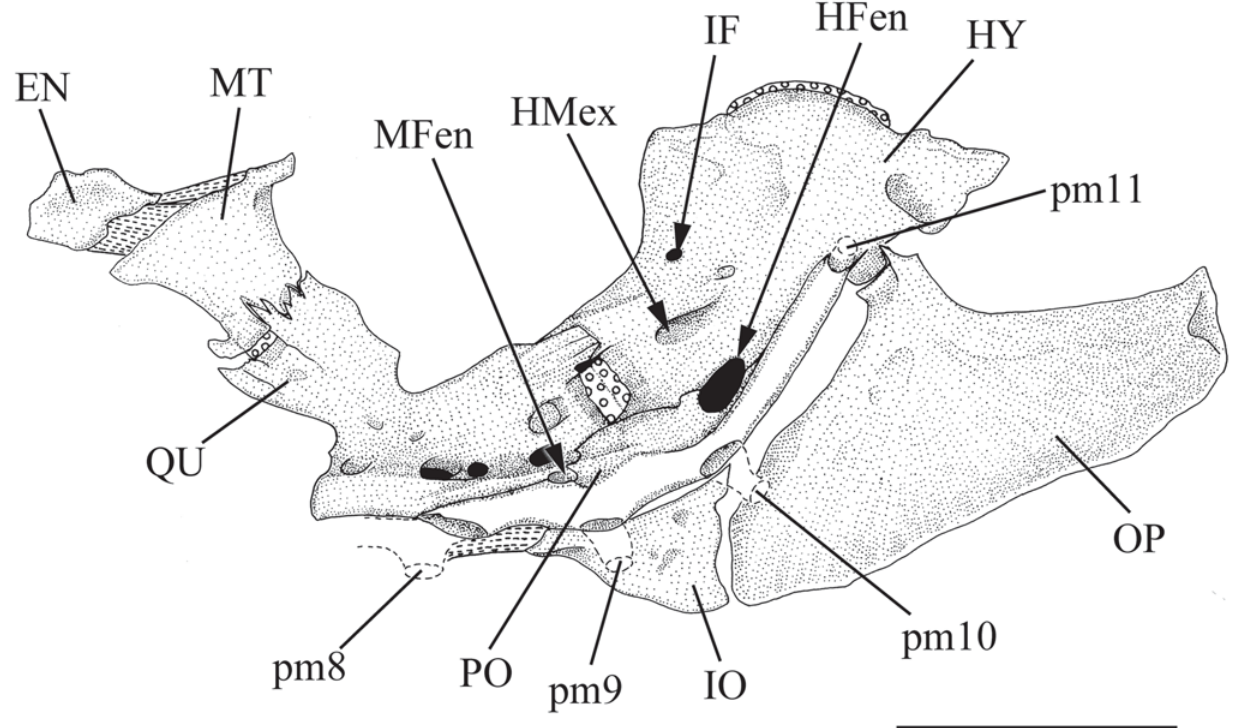
Fig. 5. Left suspensorium and opercular series of Rhamdiopsis krugi , LIRP 5928, 33.9 mm SL, paratype. Lateral view. EN ) entopterygoid; HFen ) foramen for entrance of ramus hyoideus of hyomandibular nerve trunk; HMex ) foramen for exit of hyomandibular nerve trunk; HY ) hyomandibula; IF ) foramen for exit of infraorbital trunk nerve; IO ) interopercle; MFen ) foramen for entrance of ramus mandibularis externus facialis of hyomandibular nerve trunk; MT ) metapterygoid; OP ) opercle; pm8-11 ) preoperculomandibular sensory branches 8 to 11; PO ) preopercle; and QU ) quadrate. Scale bar = 1.5